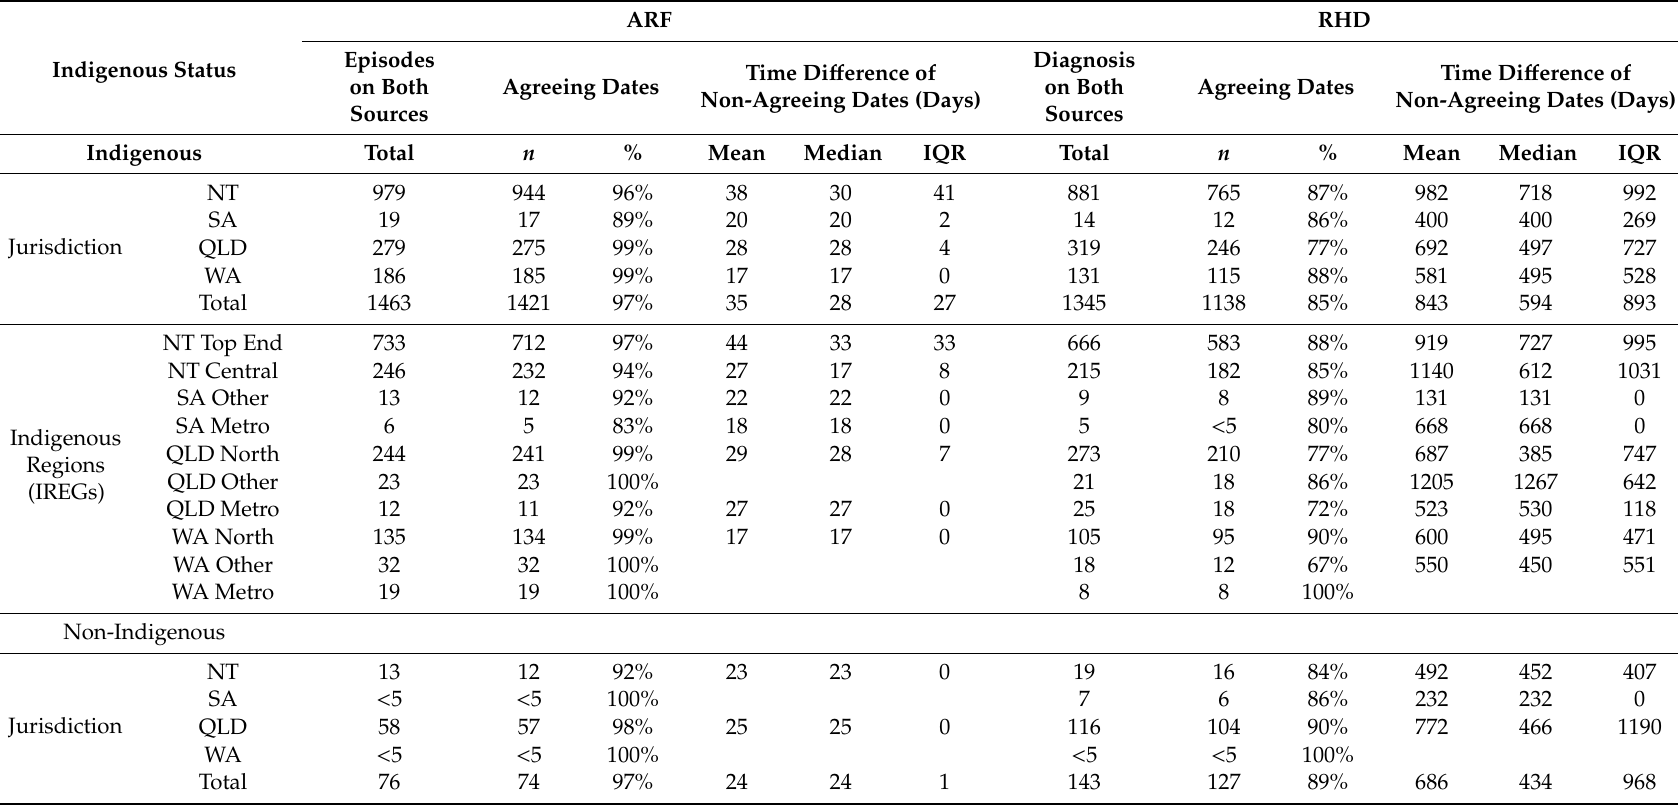
Table A4. Sensitivity analysis on the agreement between recorded diagnosis dates based on a 14-day grace period for ARF episodes and a 90-day grace period for RHD diagnosis by Indigenous status, jurisdiction and Indigenous regions.